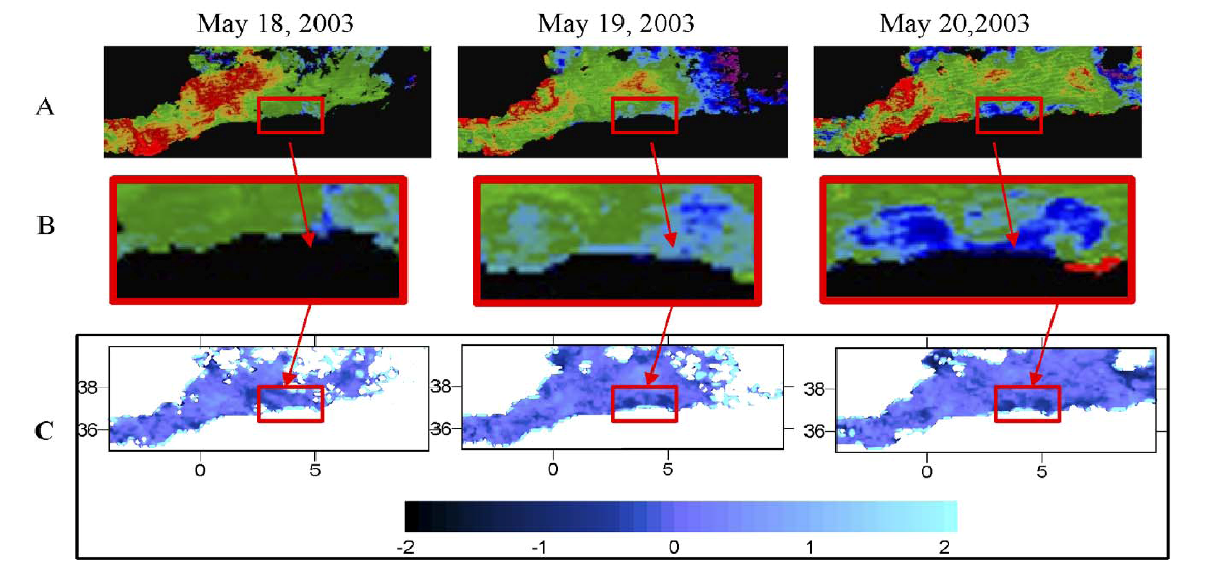
Figure 17. Sea surface temperature variation for Boumerdes earthquake (M = 6.8, 21 May 2003, Algeria). MODIS Terra LST for May 18, 19 and 20 in near zone to the epicenter. (a) Map of 4.5 km nighttime girded SST data, with red rectangle marking the upwelling area. Land is masked with black color. (b) Zoom in the epicentral area with cooling the surface temperature (blue color). (c) SST residual computed for the same days by the method of median polish